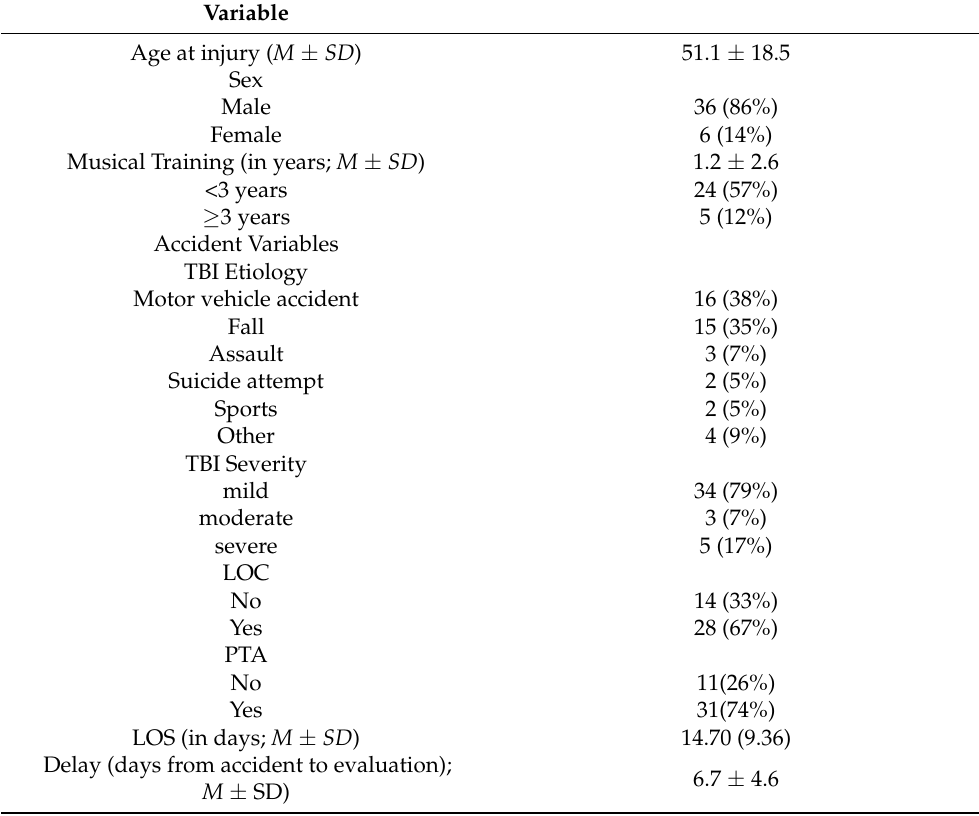
Table 1. Patient Demographics and Accident